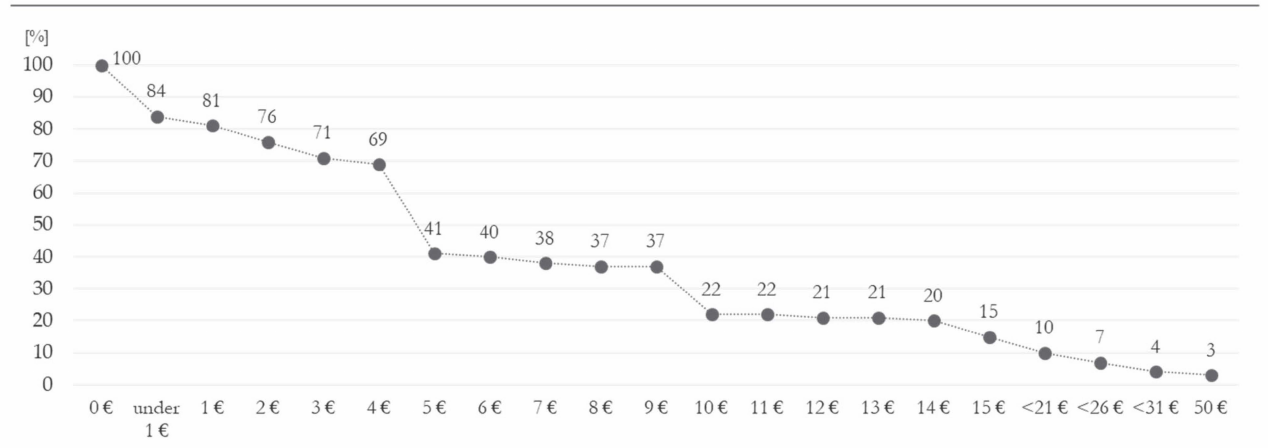
Figure 10. Readiness to pay extra (in